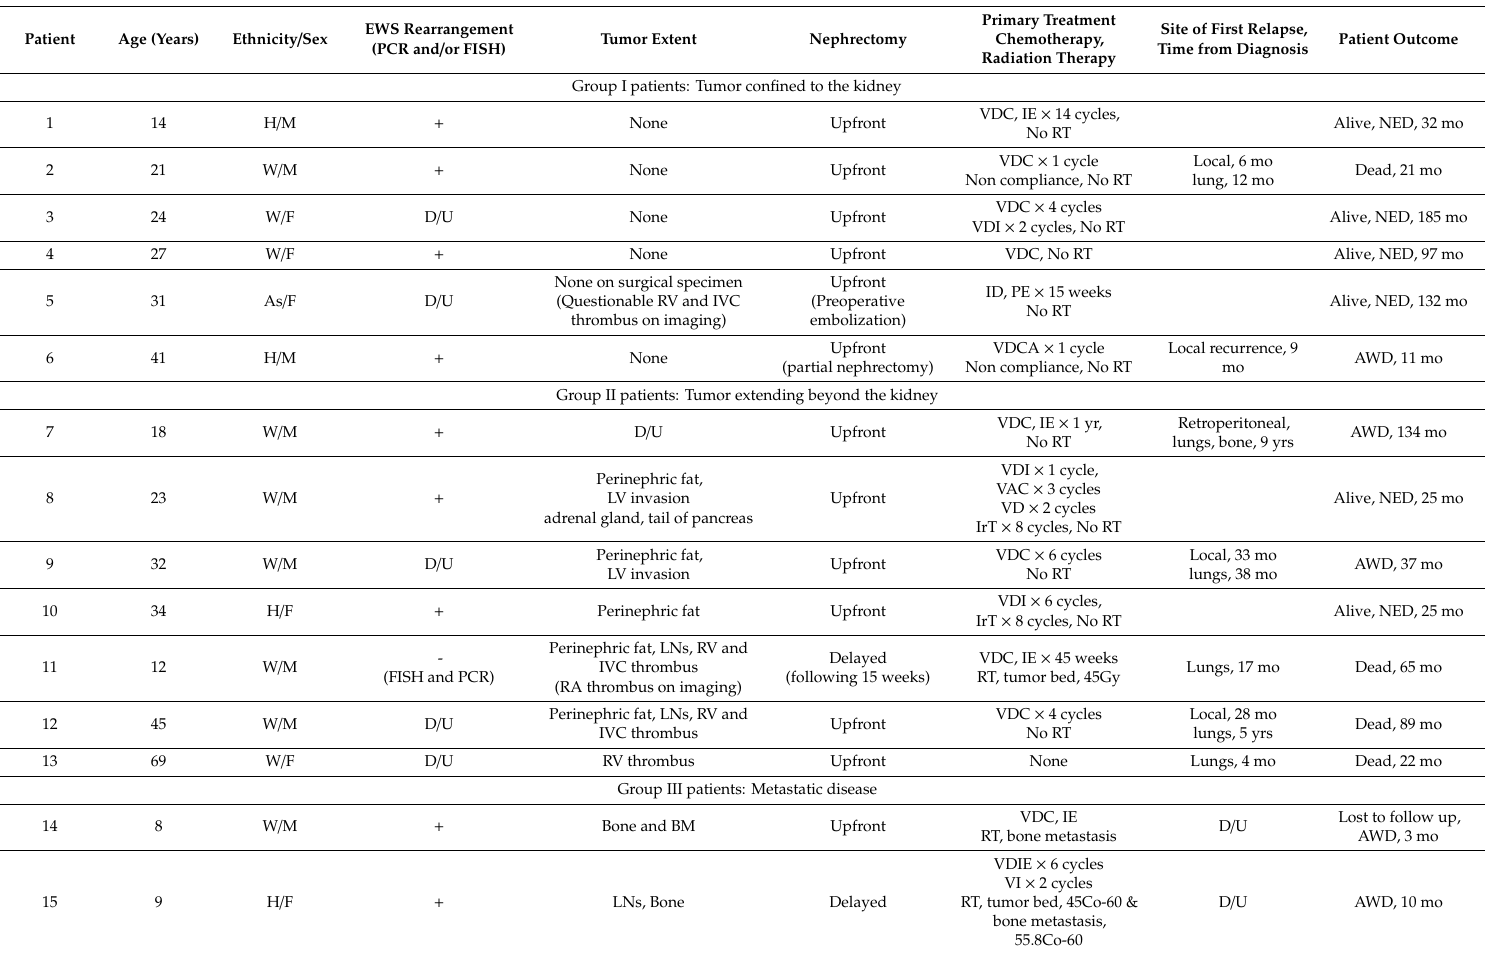
Table 2. Clinical characteristics, treatment and outcomes of 30 patients with primary ESFT of the